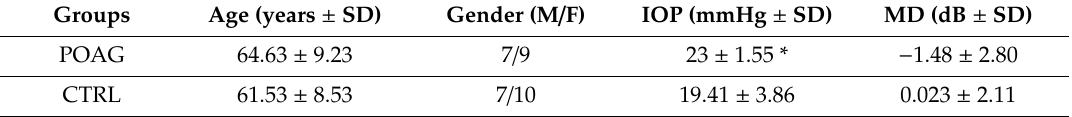
IOP = intraocular pressure, MD = mean defect, POAG = primary open angle glaucoma, dB = decibel, M = male, F = female, SD = standard deviation. * p < 0.01 versus